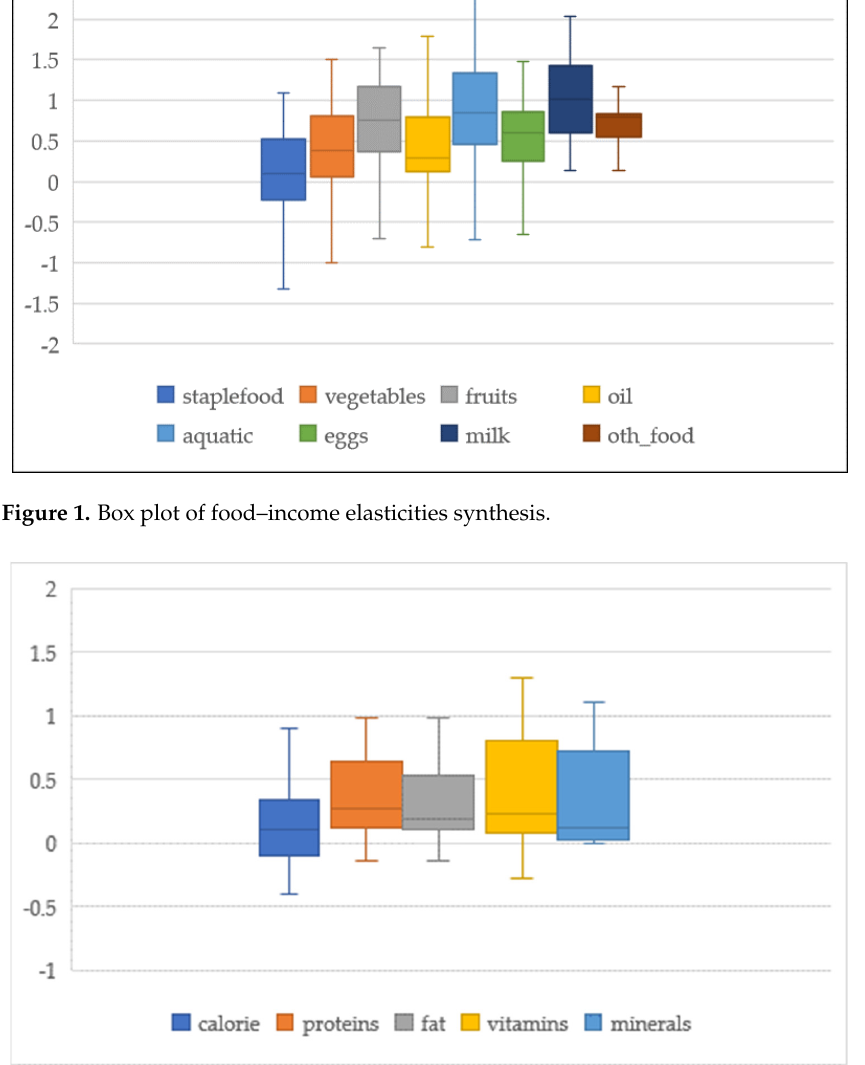
Figure 2. Box plot of calorie-, and nutrient-income elasticities synthesis.